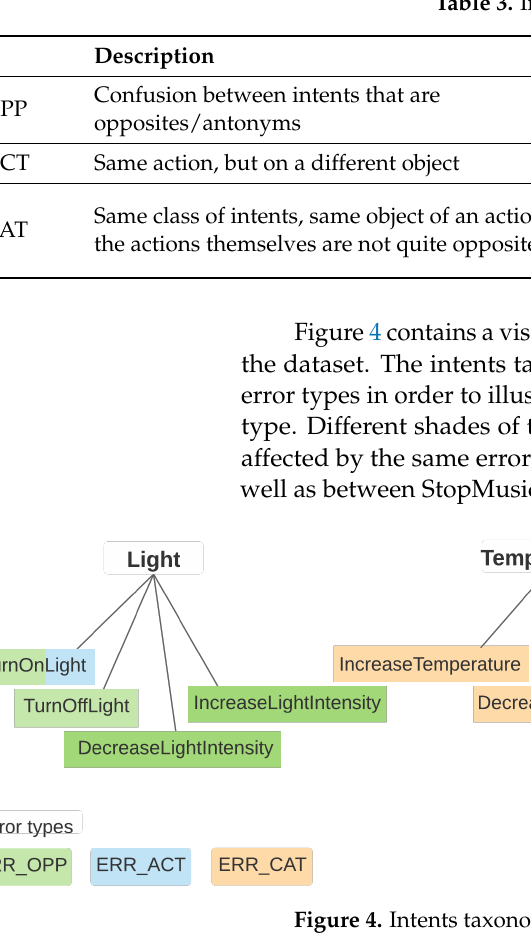
Table 3. Intent error types.